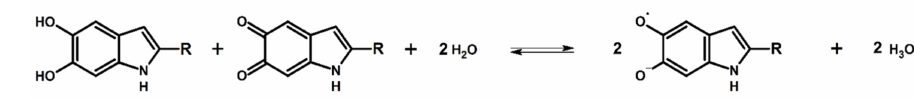
Figure 2. The comproportionation reaction. Two monomers/moieties of different oxidative states react to yield an intermediate oxidative state (the semiquinone). This figure was adapted from Chemical Physics, 546, A.B. Mostert, On the free radical redox chemistry of 5,6-dihydroxyindole, 111158, Copyright Elsevier (2021)